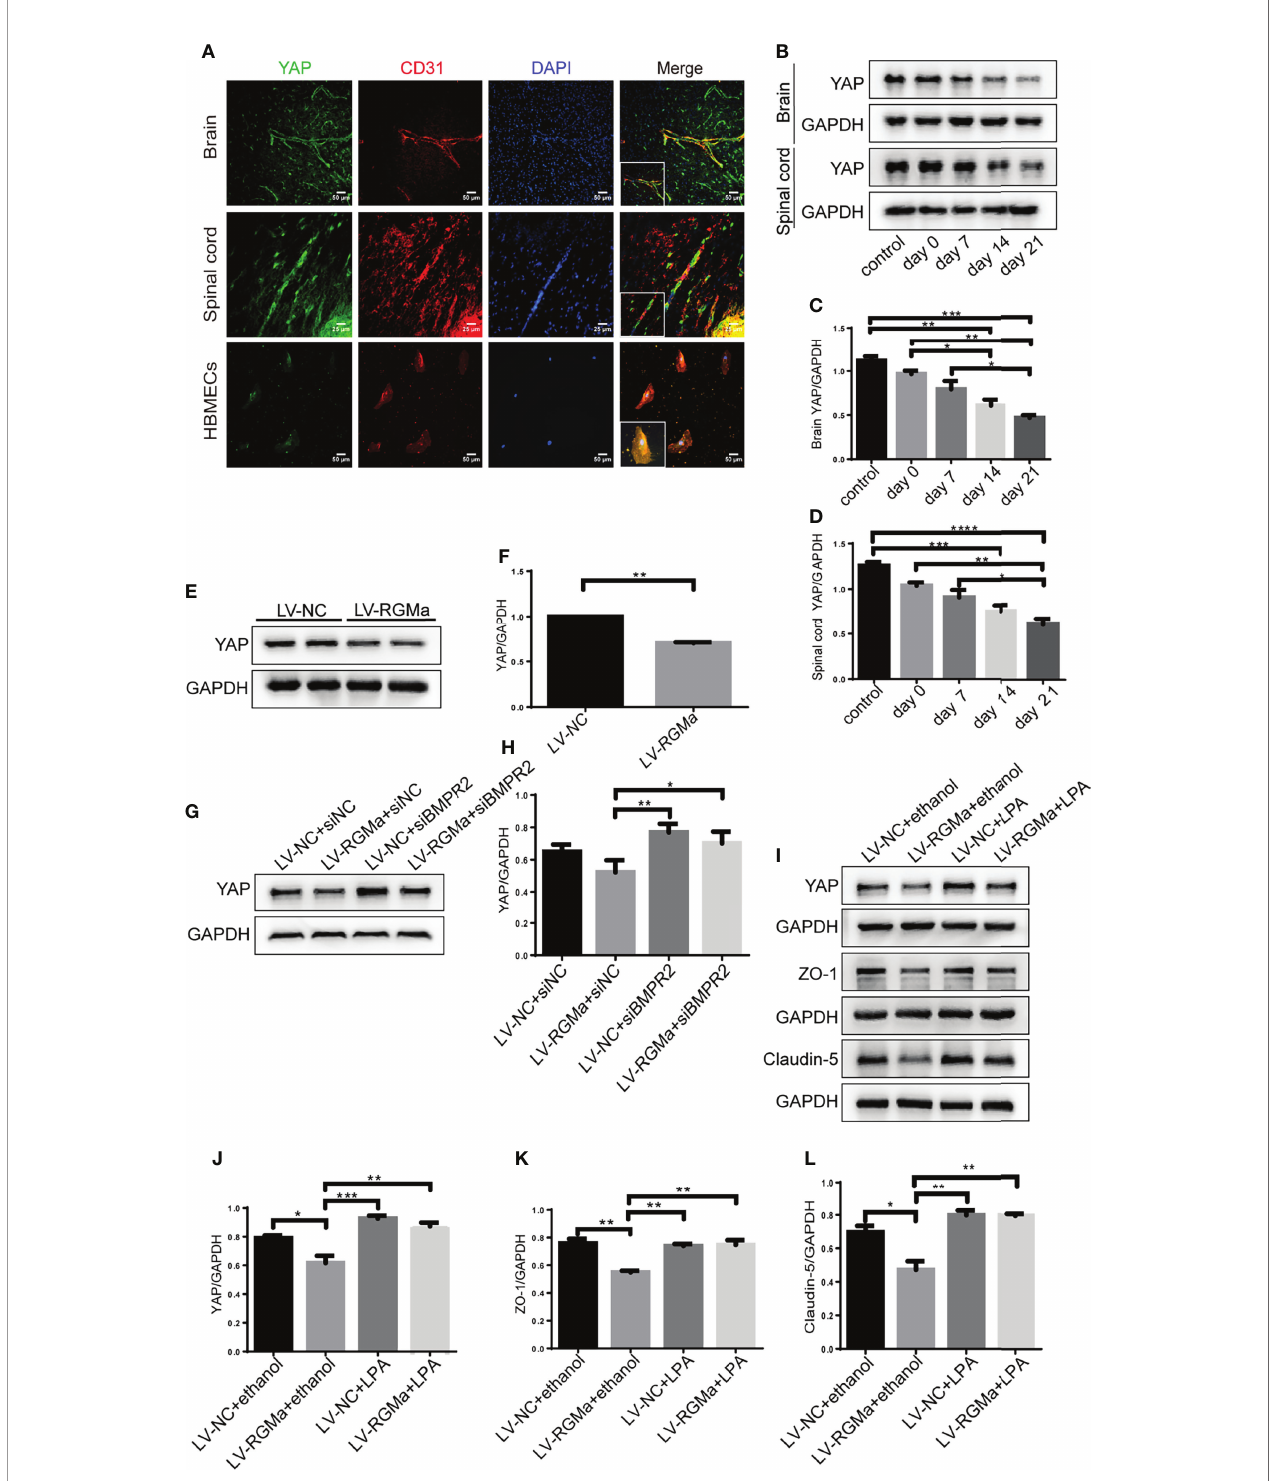
FIGURE 6 | YAP regulates RGMa-induced integrity of the BBB. (A) Immuno fl uorescence showed that YAP was expressed in CD31 + endothelial cell both in EAE mice and HBMECs. Scale bar: 50 µm (brain cortex and HBMECs) and 25 µm (spinal cord). (B – D) YAP expression gradually decreased with the progression of EAE. ( n = 4, error bar: SEM; * p < 0.05, ** p < 0.01, *** p < 0.001, **** p < 0.0001, one-way ANOVA with Bonferroni). (E, F) YAP expression was signi fi cantly diminished when overexpressing RGMa in vitro ( n = 3, ** p < 0.01, t -test). (G, H) The YAP expression level was ameliorated when blocking BMPR II ( n = 3, * p < 0.05, t -test). (I – K) By overexpressing YAP by LPA 20 µM for 2 h after overexpressing RGMa, both ZO-1 and claudin-5 were signi fi cantly increased ( n = 3, ** p < 0.01, t